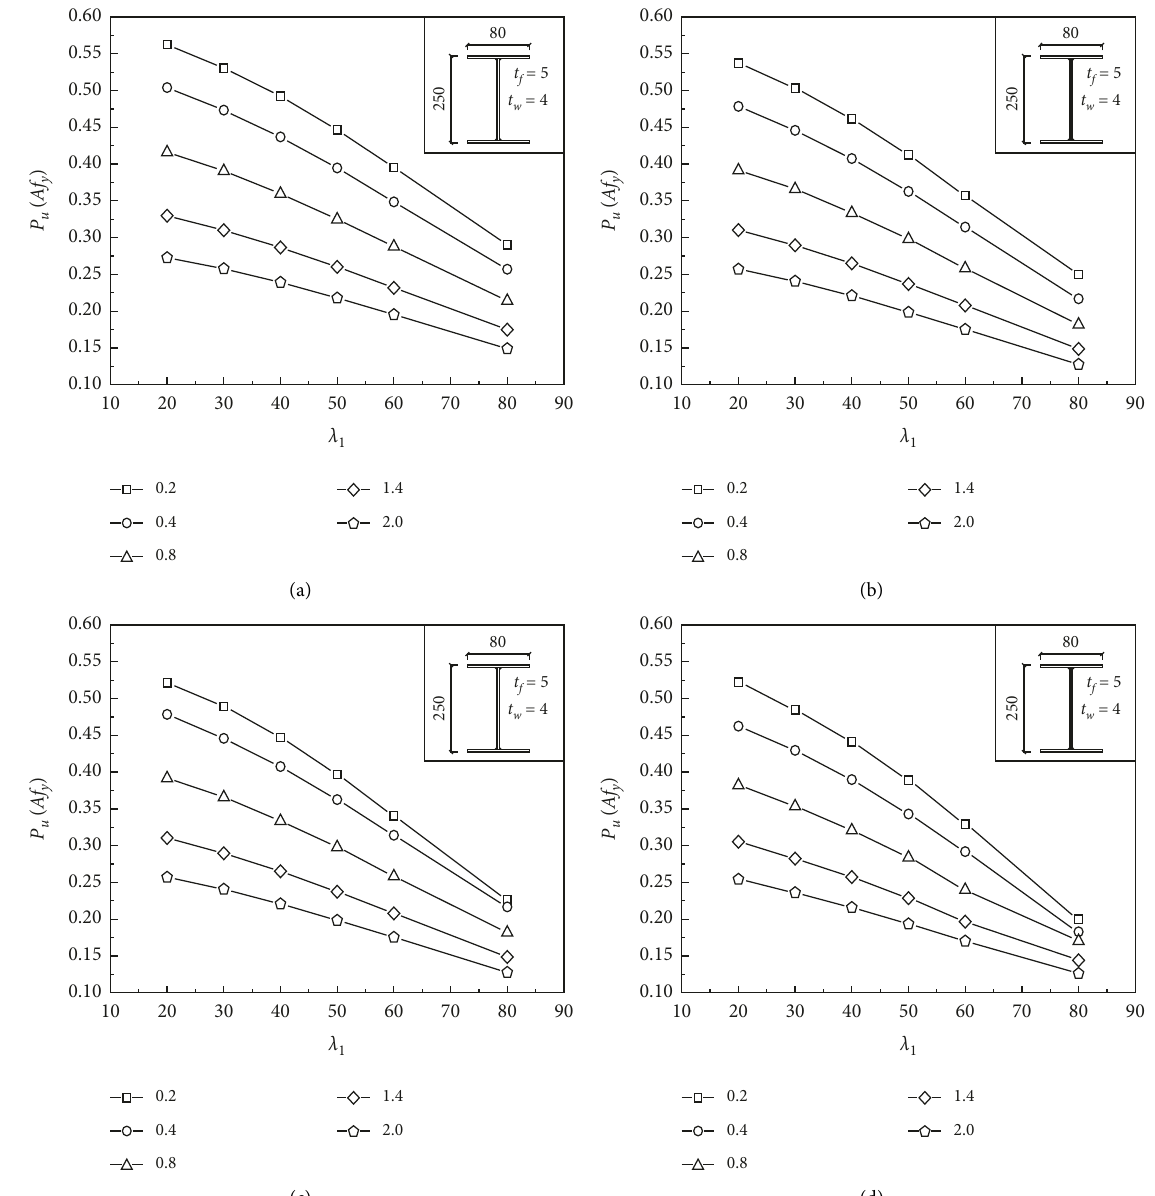
Figure 6: Axial nondimensional ultimate compressive load ( P Q690; (c) Q800, and (d)